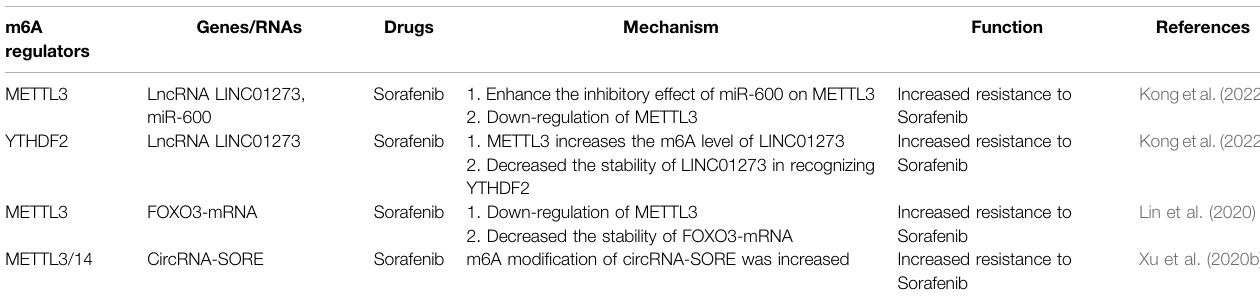
TABLE 1 | The roles of different m6A regulators in hepatocellular